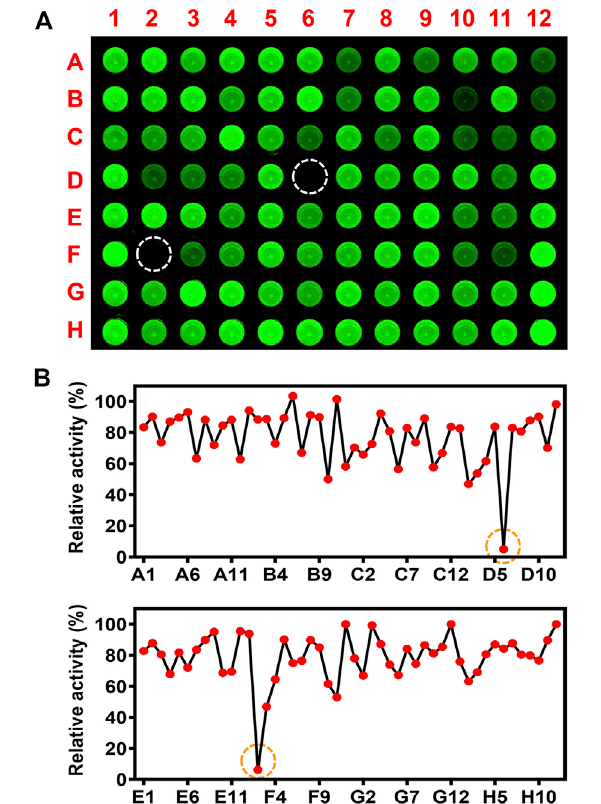
FIGURE 1 | High-throughput inhibition screening of inhibitory effects of herbal medicine towards CYP3A4. (A) Inhibition of CYP3A4 by herbal medicine extracts was determined based of their effect on the intensity of λ fl uorescence at 570±15 nm( λ ex :488 nm, em :570±15 nm,F12,G12, and H12 are control samples treated with solvent DMSO. (B) Quantitative analyses of inhibitory effects of herbal medicine towards CYP3A4. The residual activity was calculated by the volume ratio of herbal medicine and control samples (F12, G12, and